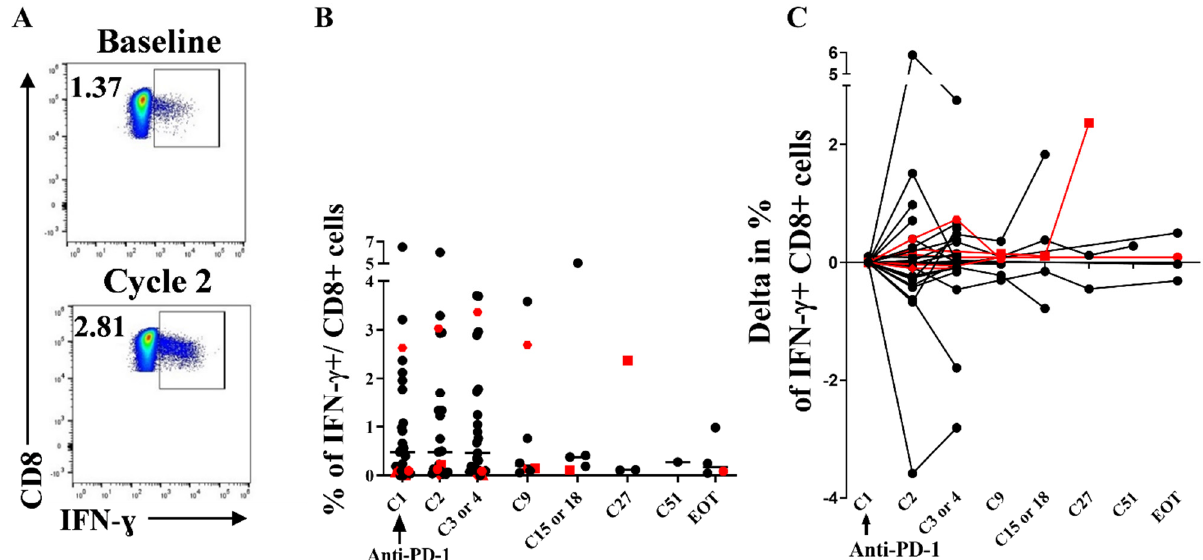
Figure 4. Anti-PD-1 therapy in PLWH with cancer does not significantly increase the in vivo fre- quency of HIV-specific CD8 + T cells. Thawed PBMC were stimulated during 6 h with HIV peptides (15 mers overlapping peptides covering RT, Nef and Gag) and then stained with intra-cellular anti- cytokine antibodies (anti-IFN- γ , anti- IL-2 and anti-TNF- α ). HIV-specific CD8 + T cells were defined as IFN- γ producing CD8 + T cells after HIV stimulation. ( A ), Example dot plots of IFN- γ expression among CD8 + T cells after HIV stimulation at baseline and at cycle 2. ( B ), frequency of HIV-specific CD8+ T cells under ICB. ( C ), HIV-specific CD8 + T cells delta from baseline under ICB. Red colors denote the RR patients. EOT: end of treatment. At cycle 1, n = 32; at cycle 2, n =29; at cycle 3 or 4, n = 29; at cycle 9, n = 11; at cycle 15, n =5; at cycle 27, n = 3; at cycle 51, n = 1; at end of treatment, n = 5. Experiments were monoplicates.